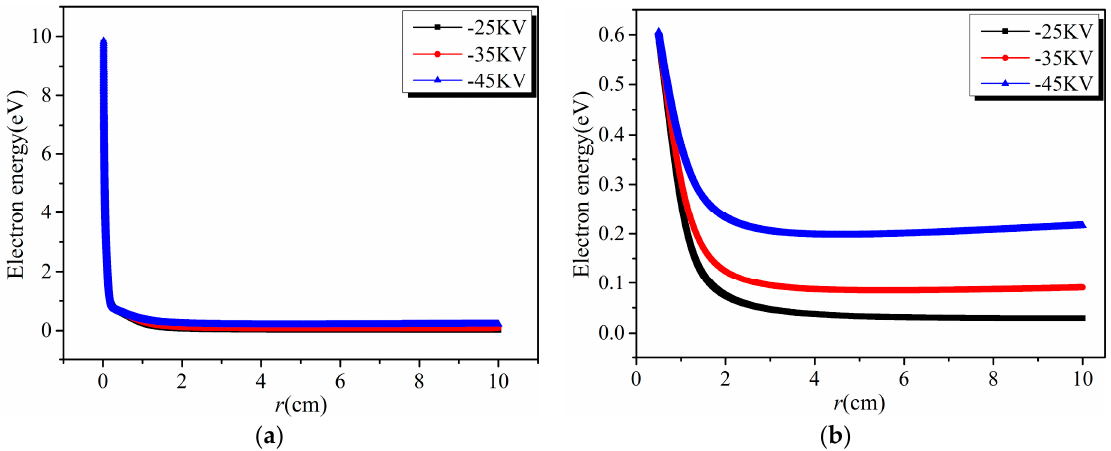
Figure 4. Effect of discharge voltage on electron energy: ( a ) Distribution of electron energy in the entire solution domain; ( b ) Distribution of electron energy in low electron energy region.